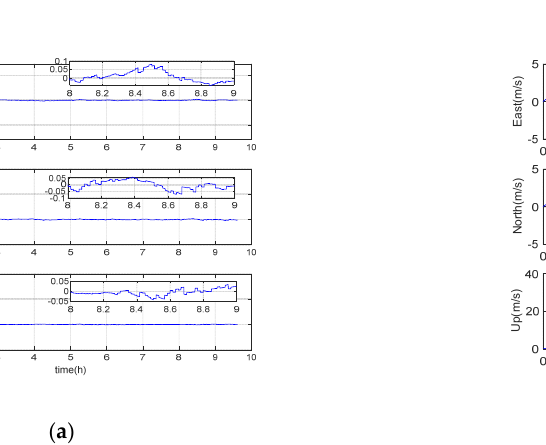
Figure 1. ( a ) Gravity gradient aided navigation (GGAN) attitude error; ( b ) pure inertial calculation attitude error.